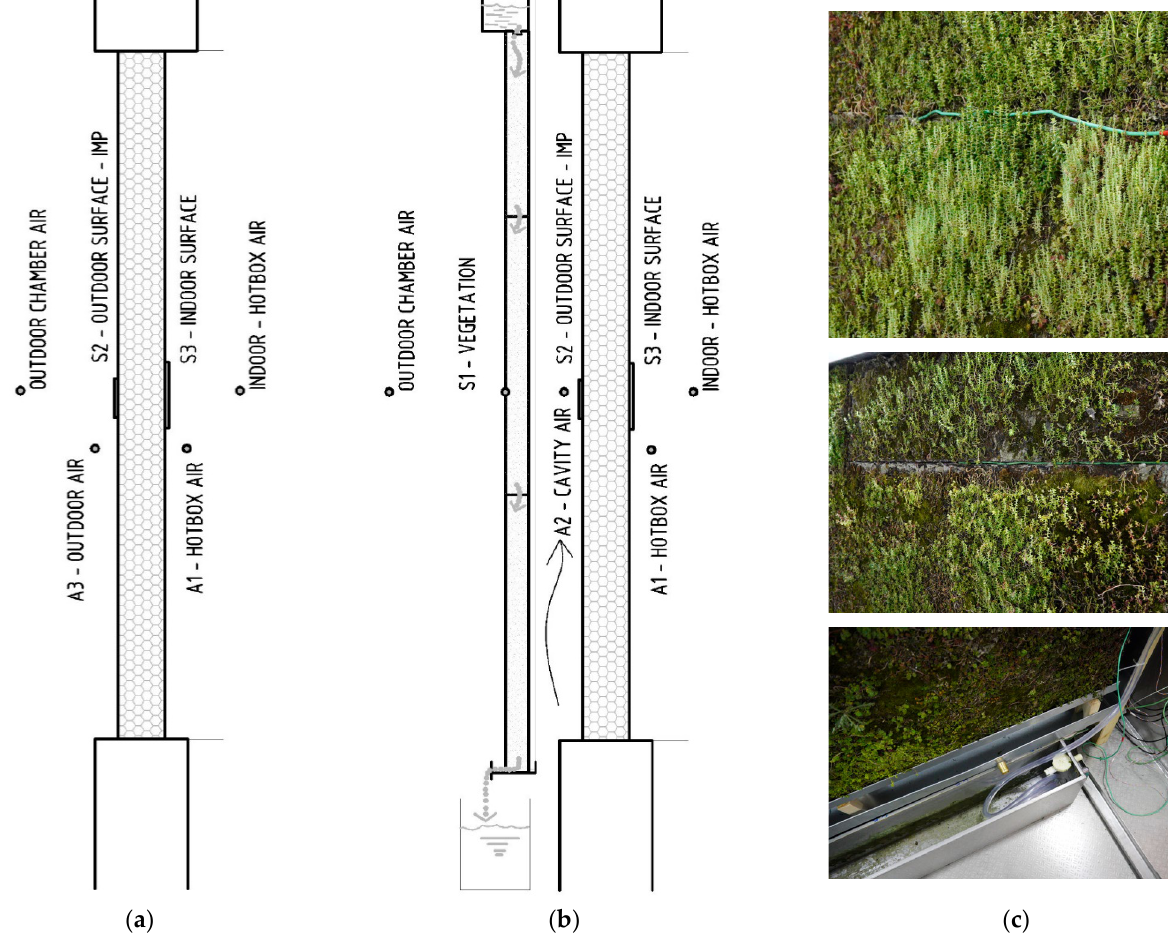
Figure 3. Scheme of the tested façade sample: ( a ) IMP-only setup, ( b ) VB setup, and ( c ) vegetation adopted to the upward orientation after vertical placement of the board, visible thermocouple cable for S1 position, bottom drainage gutter, and water